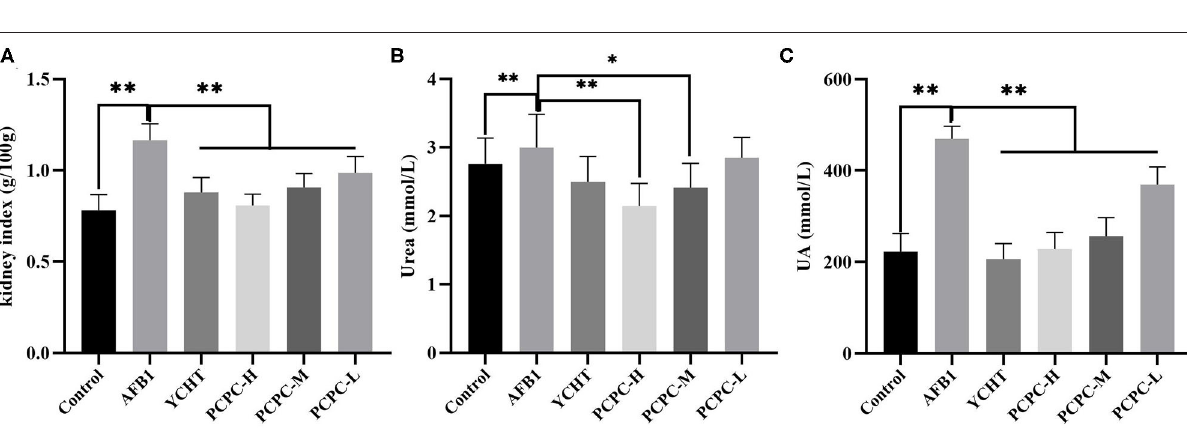
Frontiers in Veterinary Science |